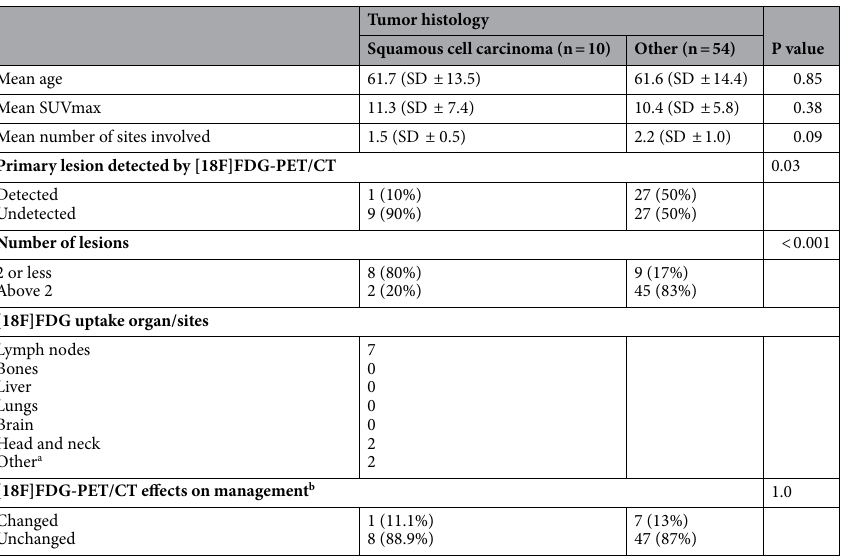
Table 3. Characteristics of patients with cancer of unknown primary site according to tumor histology: squamous cell carcinoma versus all other tumor histologies. a ‘Other’ includes the uro-gynecological system, esophagus, peritoneum, skin, colon, thyroid and muscles. b The number of patients with management data is 63, one patient with squamous cell carcinoma and an undetected primary site was lost to follow-up.